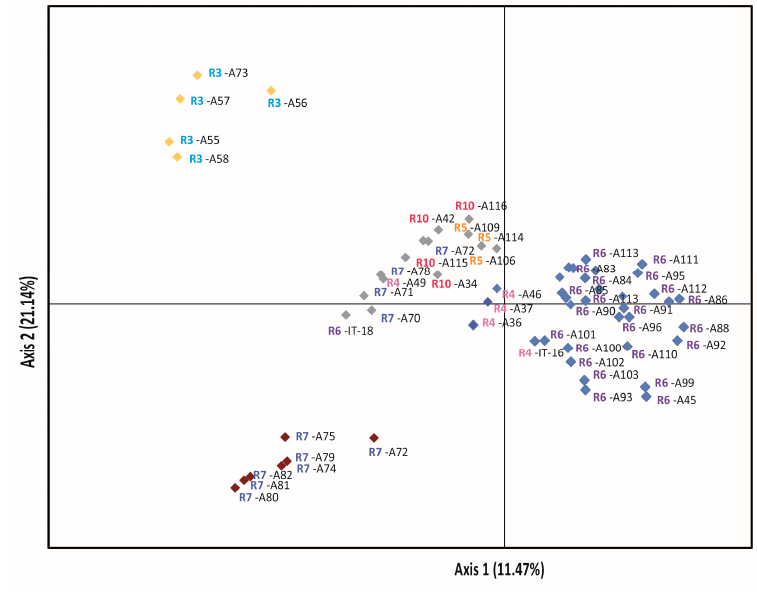
Figure 7. Principal Coordinate analysis (PCoA) of the studied Vigna unguiculata landraces using the scored nSSRs markers. Percentage of explained variance of each axis is given in parentheses. Population symbols and colors are shown in the chart. Colors of symbols indicate the four genetic groups found in STRUCTURE.